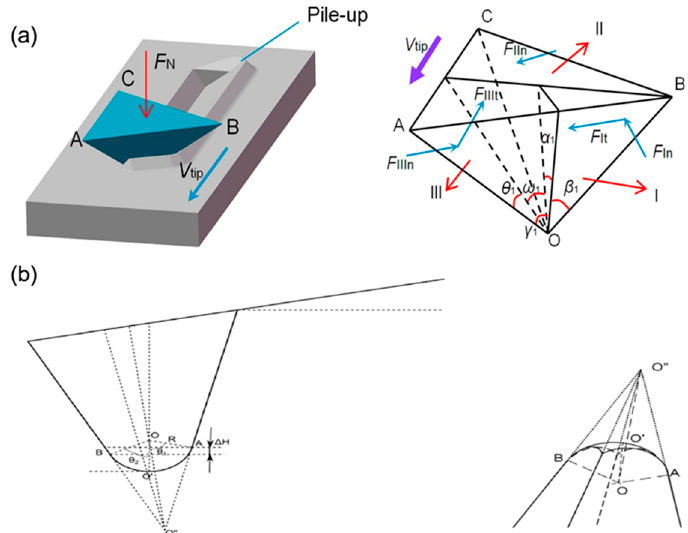
Figure 1. A simplified model of the probe: ( a ) the tip is modified as a triangular pyramid when scratching on polycarbonate (PC) bulk sample and ( b ) the tip is modified as a rectangular pyramid with a spherical apex when scratching on poly (methyl methacrylate) (PMMA) film [71,72] .